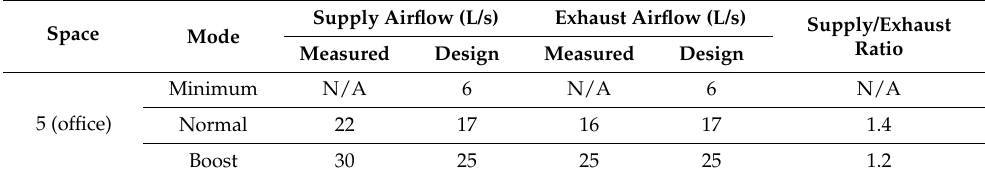
airflows was over one and led to over-pressure compared to the surrounding area. Table 8. Measured and designed airflows for Type 2 space (all-air system with minimum, normal and boost